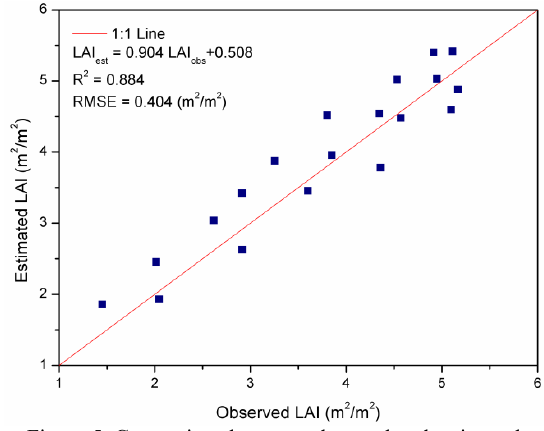
Figure 5. Comparison between observed and estimated values of LAI by RFR.